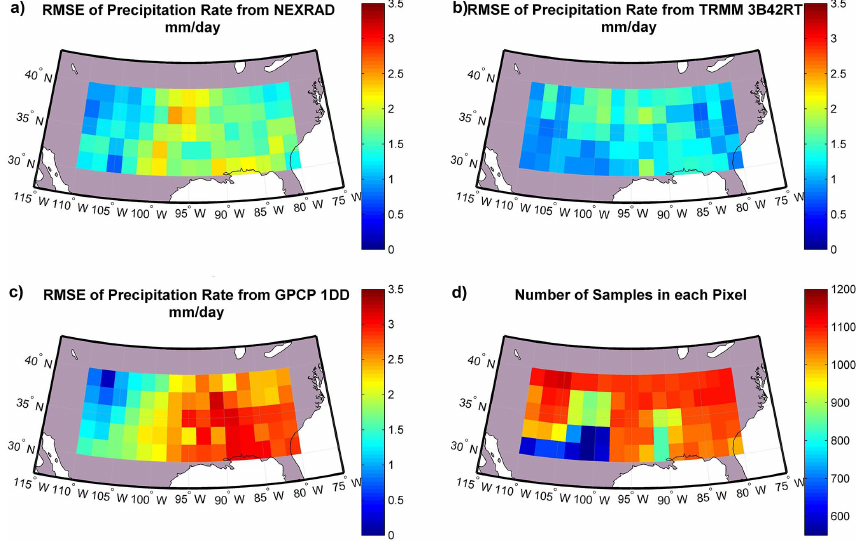
Figure 6. RMSE of the precipitation rate estimated from TC using triplets in group 2; (a) NEXRAD, (b) TRMM 3B42RT, (c) GPCP 1DD. (d) shows the number of data points (biweekly measurements) in each pixel that are used for error estimation in TC